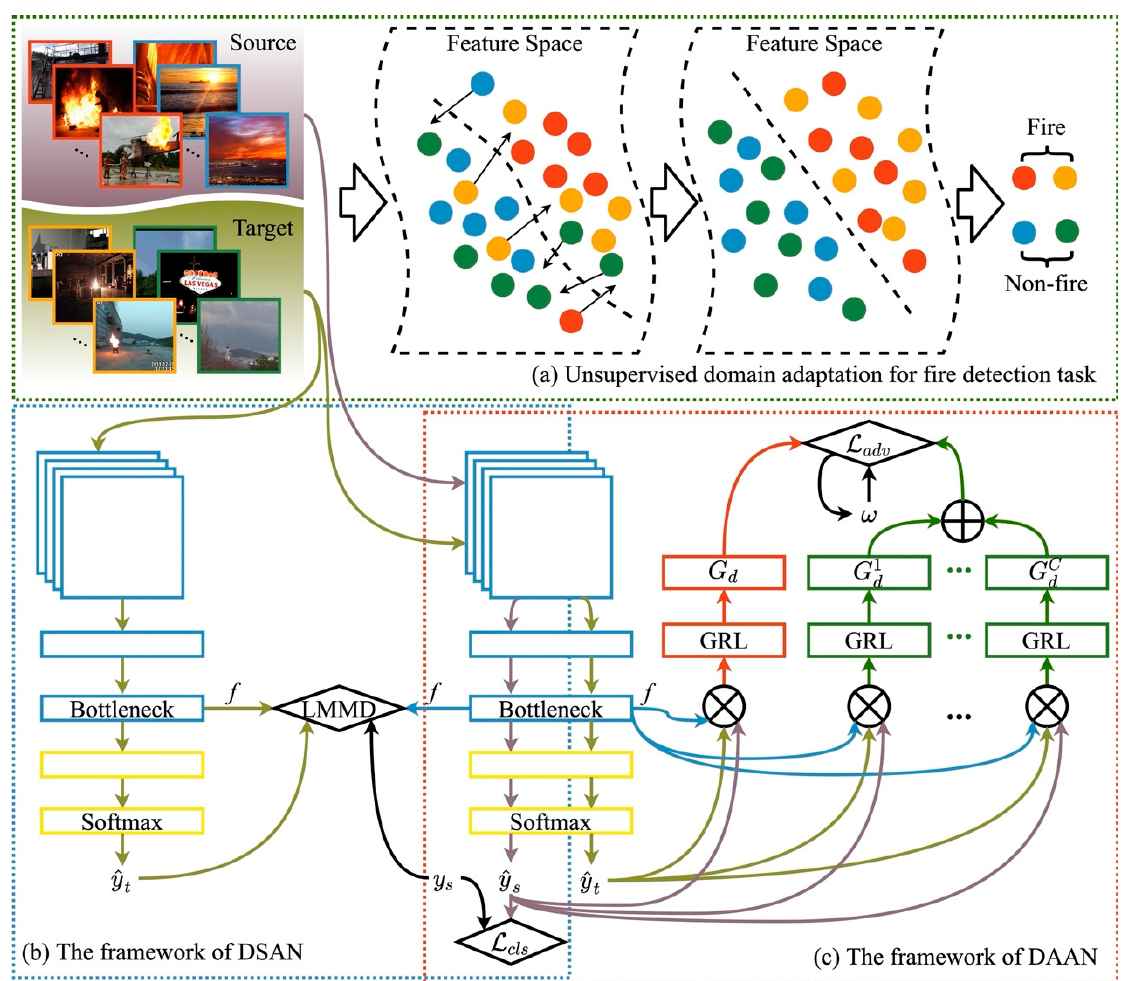
Figure 1. The UDA framework for fire recognition in this paper, including the feature alignment flowchart ( a ), DSAN ( b ), and DAAN ( c ).